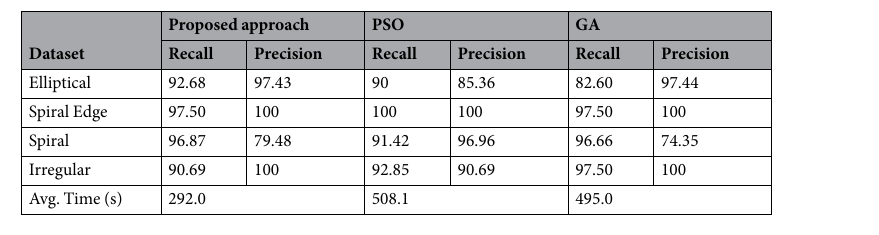
Table 3. A comparison between the proposed approach and the PSO and GA methods for galaxy image retrieval.